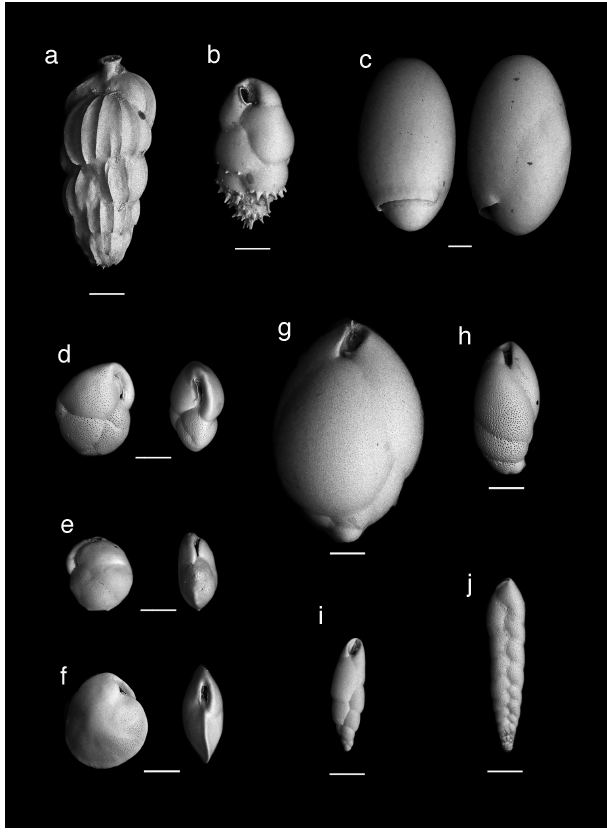
Fig. 3. Scanning electron microscope images of studied species. (a) Uvigerina akitaensis , (b) Bulimina aculeata , (c) Chilostomella ovoidea , (d) Cassidulina norvangi , (e) Takayanagia delicata , (f) Is- landiella norcrossi , (g) Globobulimina auriculata , (h) Rutherfor- doides cornuta , (i) Stainforthia loeblichi , and (j) Brizalina pacifica . Scale bars represent 100µm. (a) , (c) , (d) , (e) , (f) , (i) and (j) ; Sea of Okhotsk; (b) , Nankai Trough; (g) and (h) , Sagami Bay.